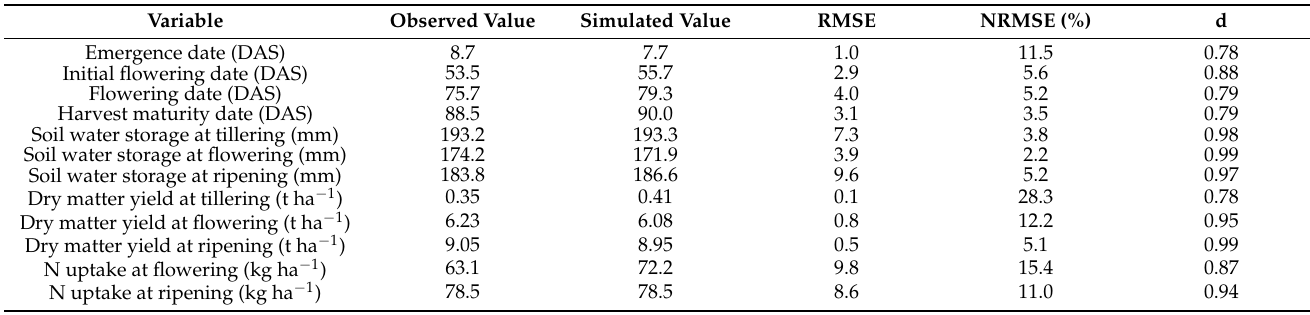
Table 3. Statistics of the performance of APSIM in model